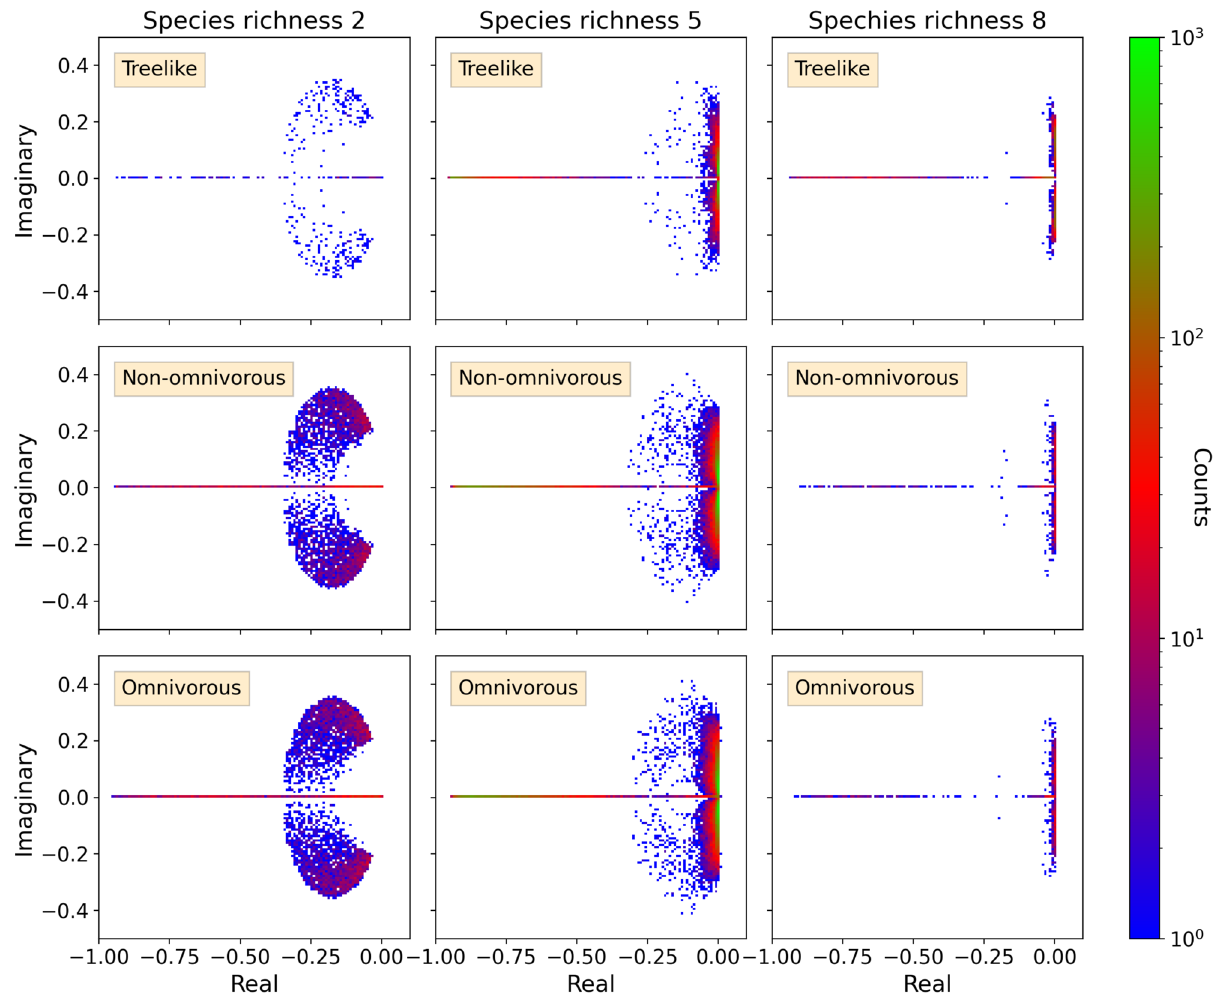
Figure 3. Complex eigenvalue spectra of evolved food webs. Each panel represents the two-dimensional histogram in the complex plane. Species richness and invasion mechanism are as labelled in panels, that is, rows of panels represent treelike, non-omnivorous, and omnivorous food webs. Note that the colour scale is logarithmic, with green marking the areas with largest likelihood of eigenvalues (Details: “Materials and methods”). Eigenvalue spectra of omnivorous food webs of other species richnesses can be seen in Fig.